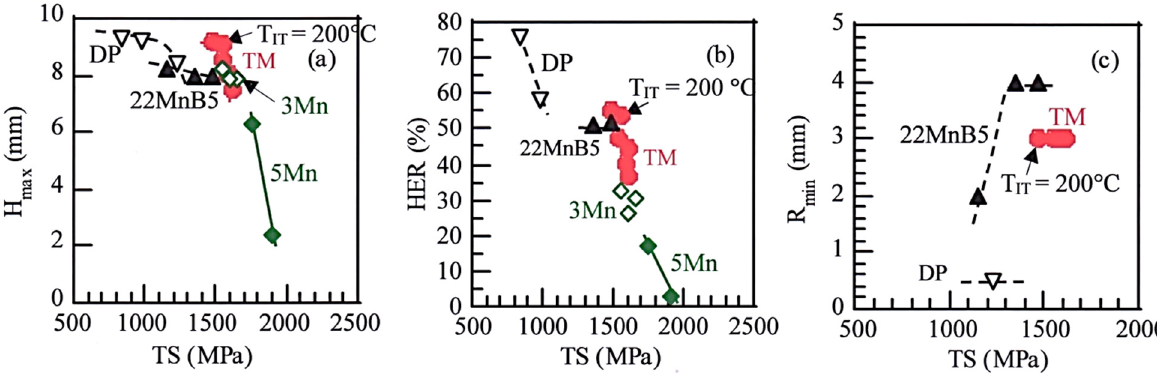
Figure 7. Relationships between ( a ) maximum stretch height ( H max ), ( b ) hole expansion ratio (HER) and ( c ) minimum bending radius ( R min ), and tensile strength (TS) in 0.21%C–1.49%Si–1.50%Mn–1.0%Cr–0.05%Nb TM steel subjected to the DQ process or the IT process at T IT = 100 to 250 ° C for 1000 s ( ● ). DP ( ▽ ): 0.082%C–0.88%Si–2.0%Mn ferrite–martensite dual-phase steel, DIN- 22MnB5 ( ▲ ): 0.23%C–0.19%Si–1.29%Mn–0.21%Cr–0.003%B Q&T steel [61], 3Mn ( ◇ ): 0.2%C–1.5%Si–3%Mn M-MMn steel subjected to the DQ process and the IT process at T IT = 200 ° C, 5Mn ( ◆ ): 0.2%C–1.5%Si–5%Mn M-MMn steel subjected to the DQ process and the IT process at 100 ° C [66]. This figure was reproduced from Refs. [61,66]. Ref. [61] is reprinted with permission from AIST: AIST 2013, Copyright 2021.